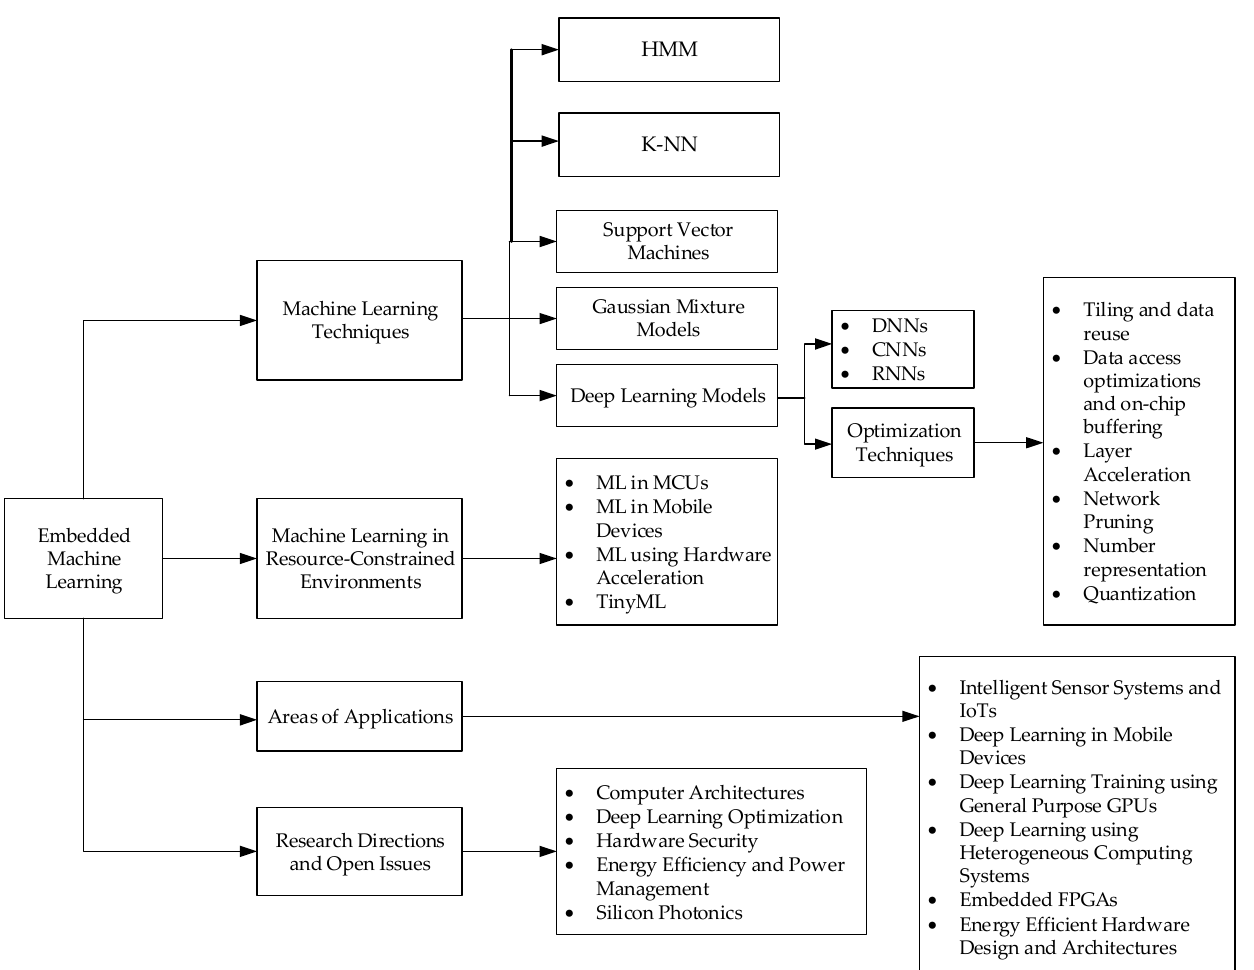
Figure 1. The layout of Embedded Machine Learning Computing Architectures and Machine Learning and Optimization Techniques.